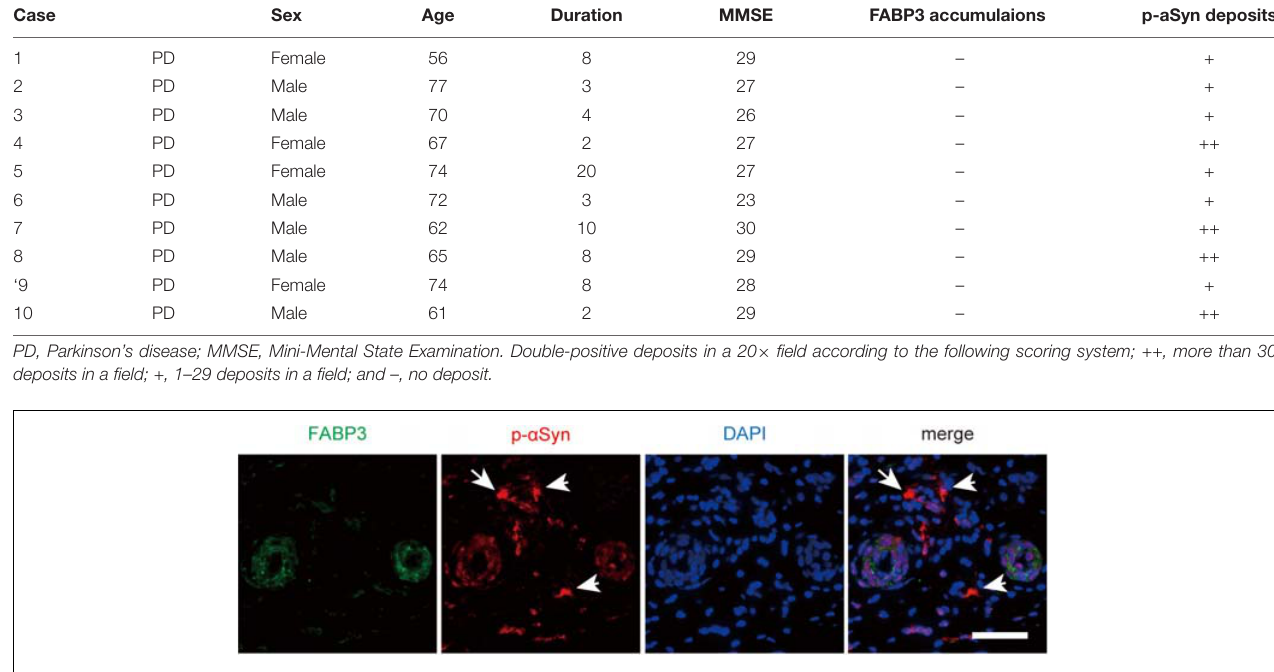
TABLE 2 | Demographic profiles of PD patients with skin biopsy tissues and the results of immunostaining for FABP3 accumulations and p- α Syn deposits. Case Duration